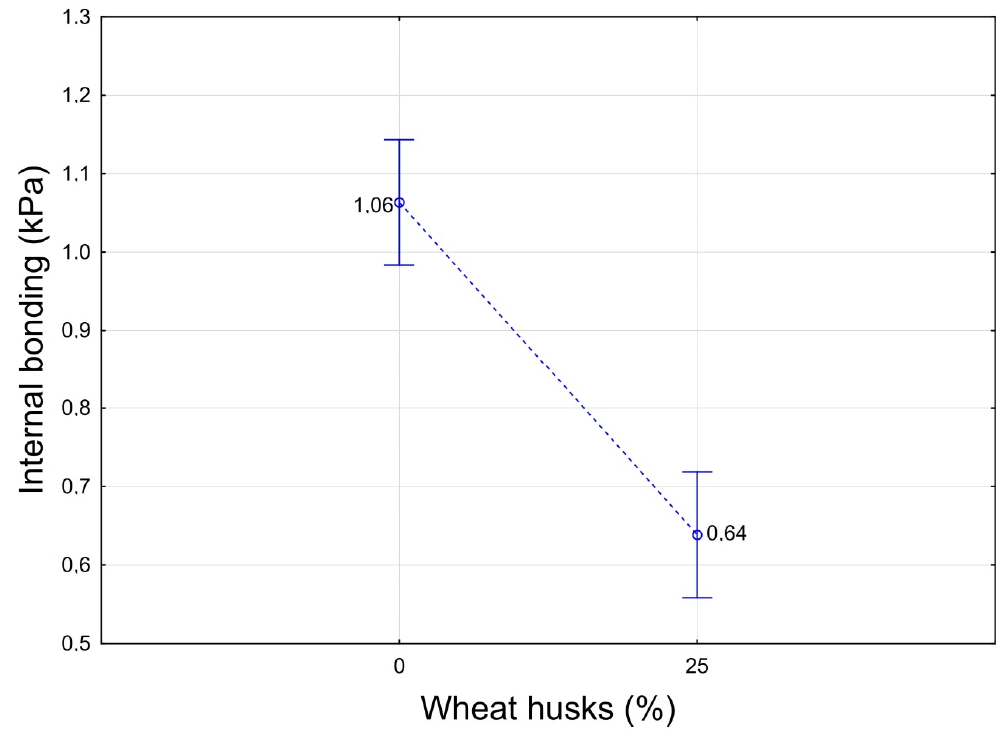
Figure 7. Influence of the proportion of the husk in the insulation board on internal bonding of composite materials.